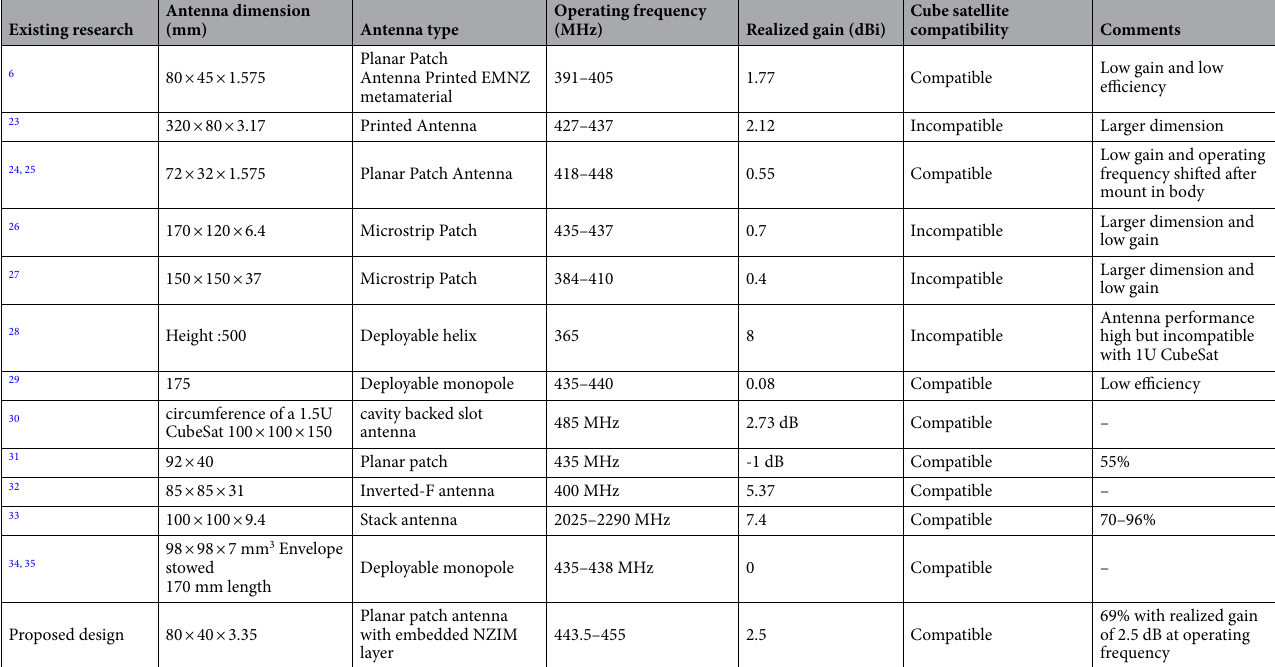
Table 3. A comparison of the proposed MTM loaded Patch antenna with existing UHF cube satellite